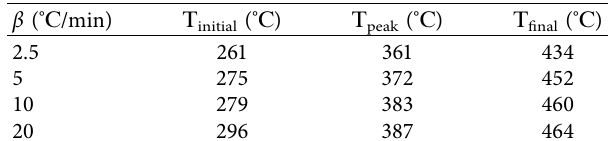
Figure 1: TGA (a) and DTG (b) curves of p-EGF:AA, 44.05:55.95mol% obtained at different heating Table 2: Thermogravimetric data for p-EGF:AA copolymer, 44.05: 55.95mol% at various heating rates.